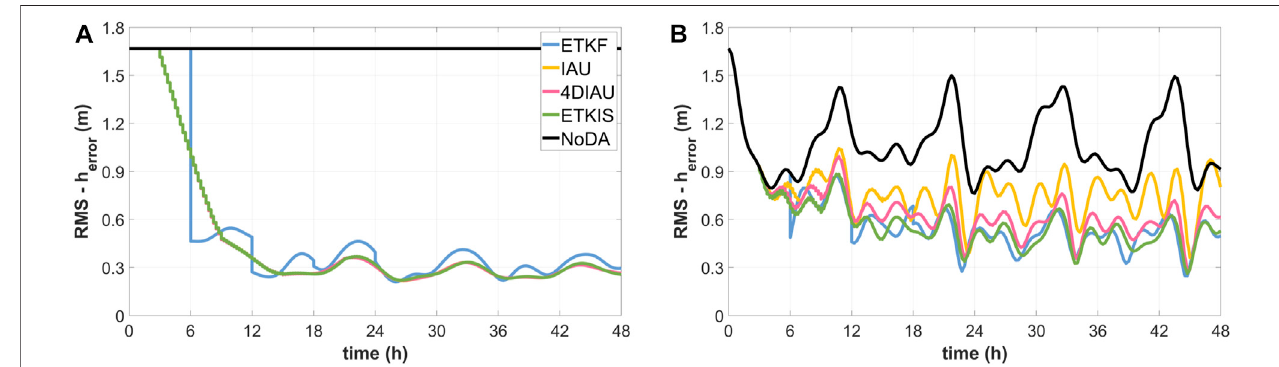
FIGURE1 | Thetimeseries ofRMSE ofthe h variable in (A) theexperiment with balanced initial conditions and (B) theexperimentwithimbalanced initial condition.